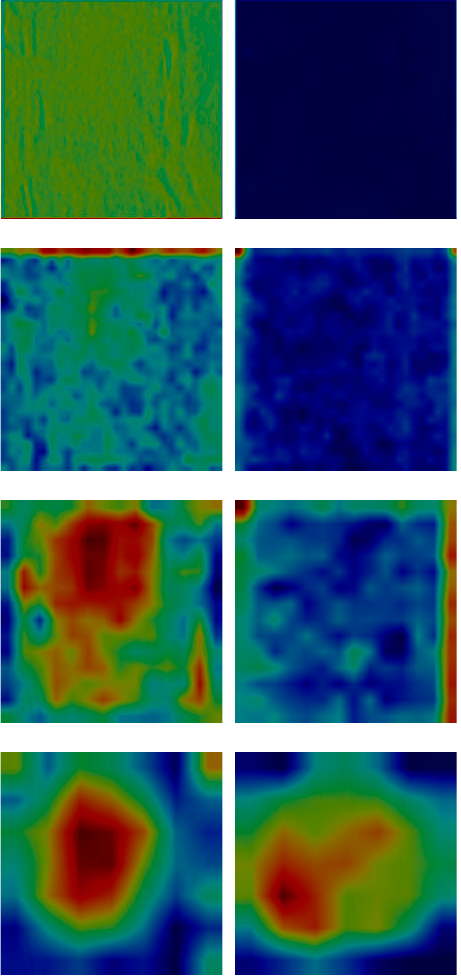
Figure 37. Incorrect recognition examples after restoring motion and optical blur. ( a ) Incorrect gen- uine matching before restoration, ( b ) incorrect genuine matching after restoration, ( c ) incorrect im- poster matching before restoration, and ( d ) incorrect imposter matching after restoration. From the left, examples in ( a – c ) and ( d ) present the enrolled, matching, and difference images,